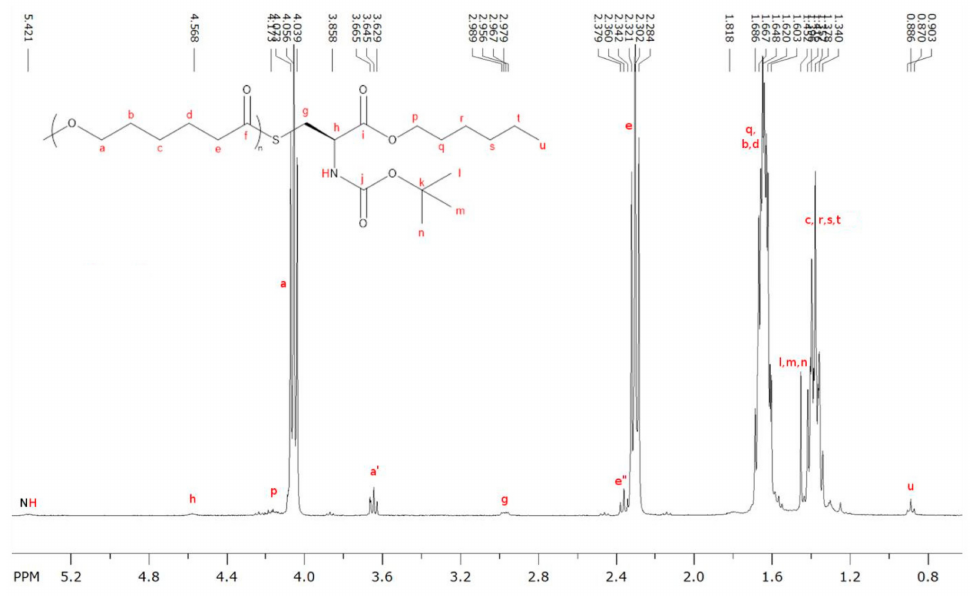
Figure 4. 1 H-NMR of polymerization product between CL and 10 mol % of N -Boc Cys HE.